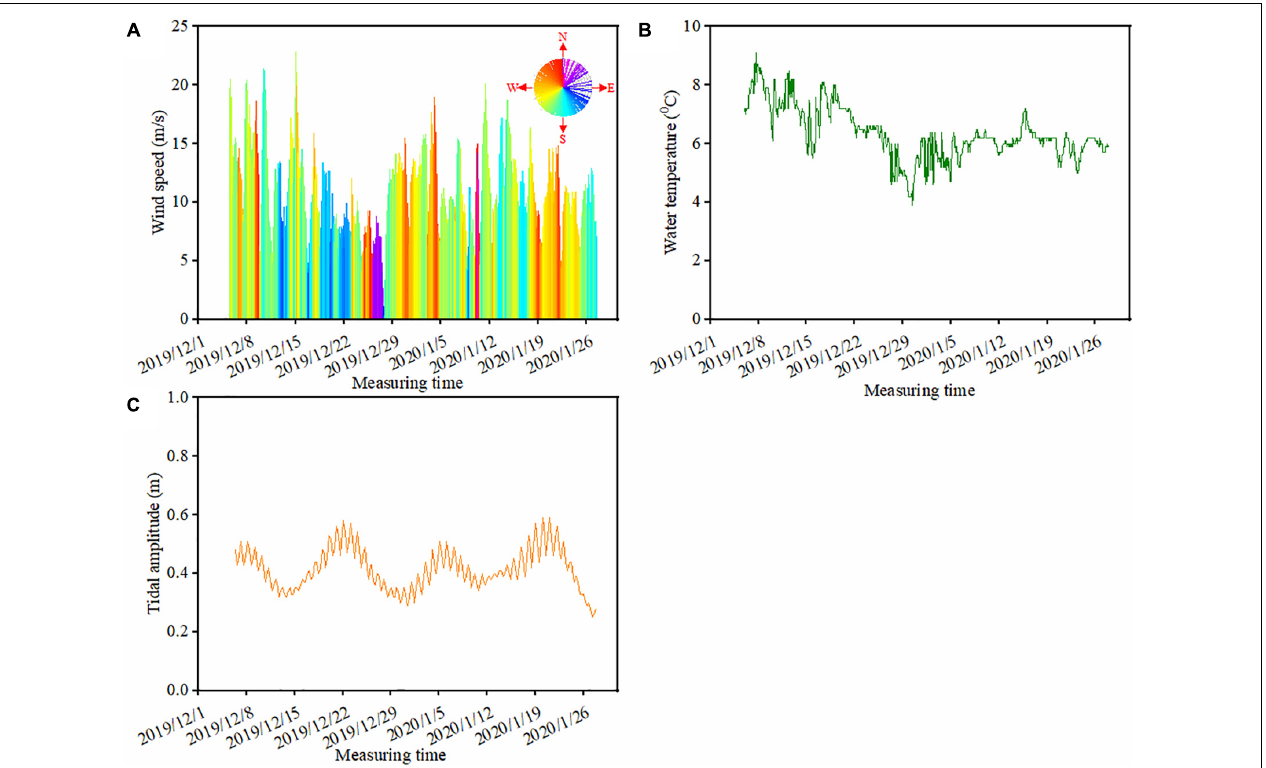
FIGURE 3 | Variation in the ambient environmental factors at the study beach during the monitoring period. Panel (A) is the hourly wind data, where the color of the wind rose in panel (A) indicates the wind direction (0–360 ◦ ) and the height of the column represents the wind speed (m/s). Panel (B) is the hourly water temperature ( ◦ C) and panel (C) is the daily tidal amplitude, representing the difference between the high and low tides (m).